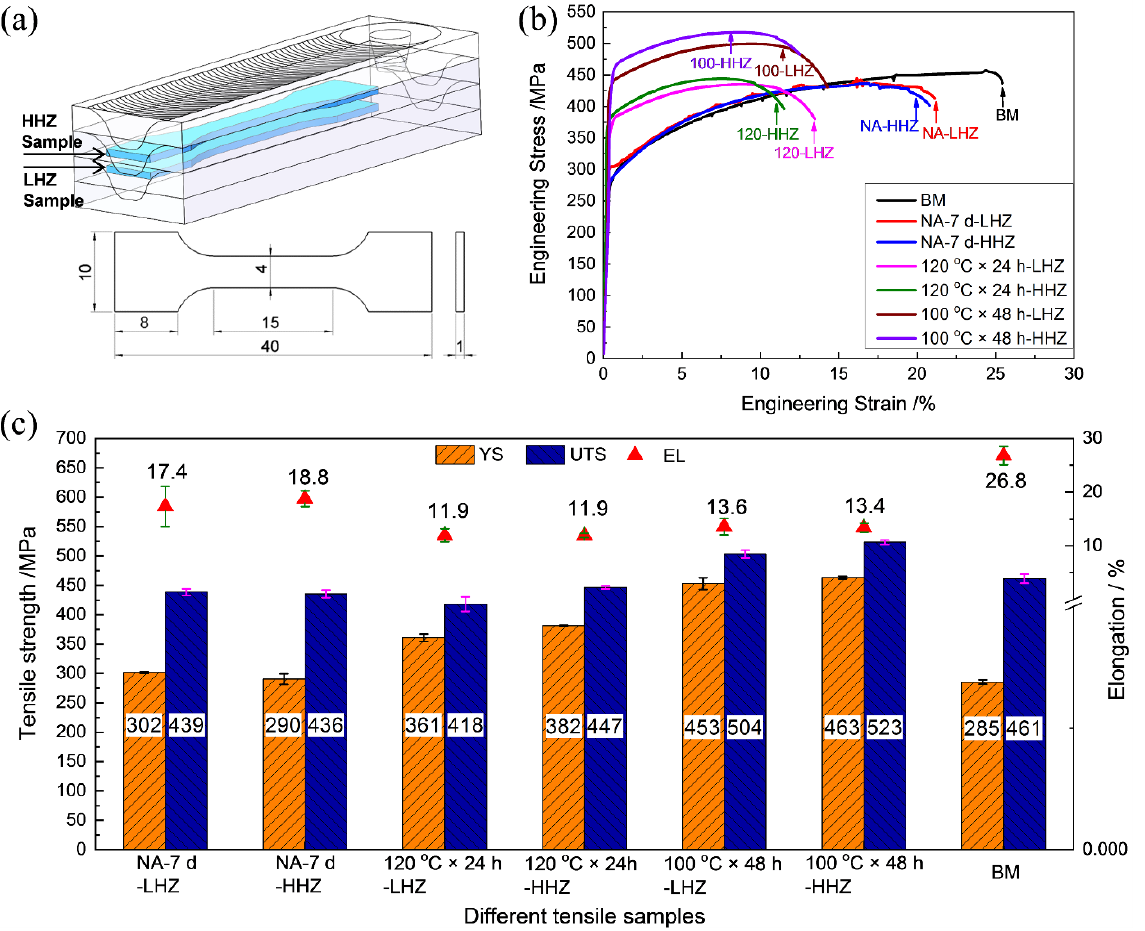
Figure 3. Tensile properties of the samples extracted from the low hardness zone (LHZ) and the high hardness zone (HHZ) of the builds in the NA-7 d, 120 ◦ C × 24 h, and 100 ◦ C × 48 h states: ( a ) schematic of the extraction position and dimension of the tensile samples (units: mm); ( b ) engi- neering stress–strain curves of the typical tensile samples; and ( c ) tensile strength and